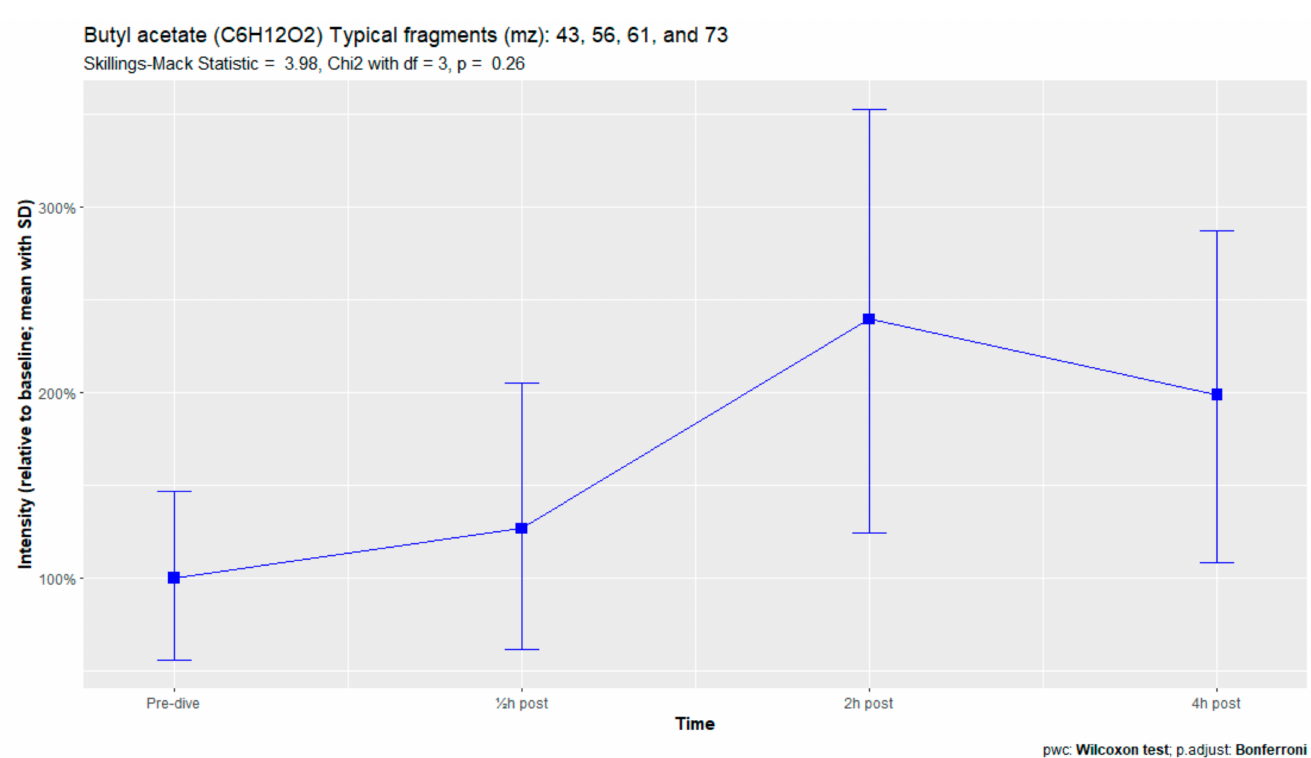
Figure A10. Butyl